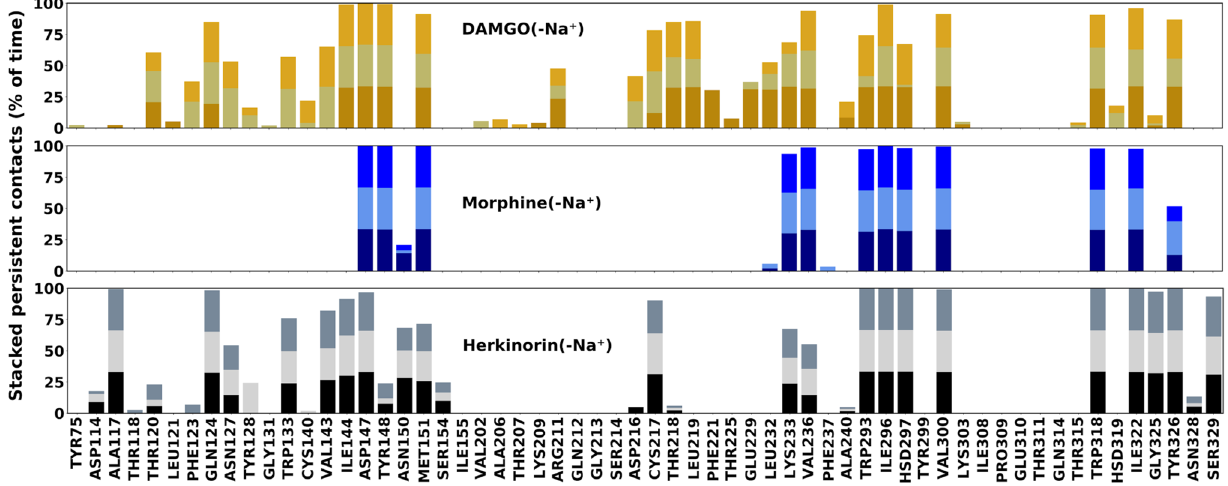
Fig. 5 Amino acid–ligand contact probabilities of DAMGO, morphine, and herkinorin in μ-OR. Percentage occupancy of protein–ligand con- tacts within 4.0 Å during the MD simulations. Simulation replicas are differentiated by color